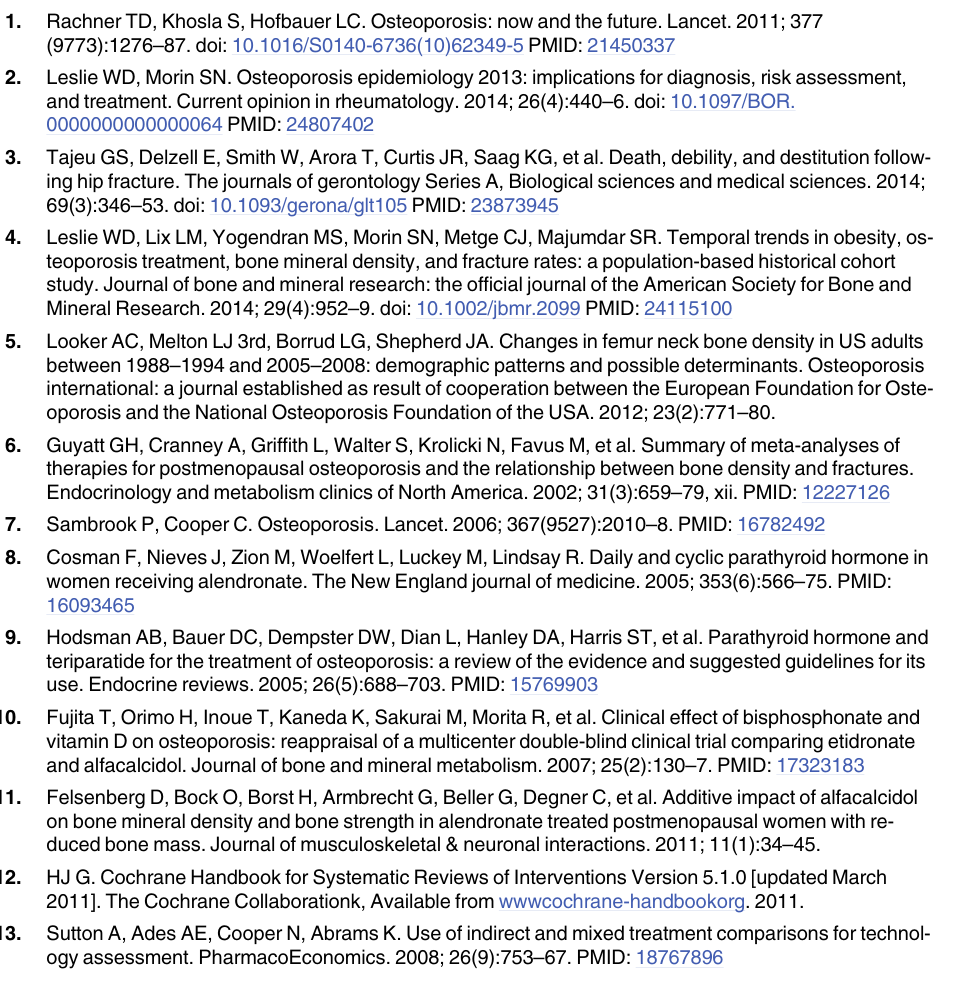
S4 Table. Sensitivity analysis: the BMD in LS for different treatments (exclude trials with a high risk of bias). S5 Table. Sensitivity analysis: the fracture rate for different treatments (exclude trials with a high risk of